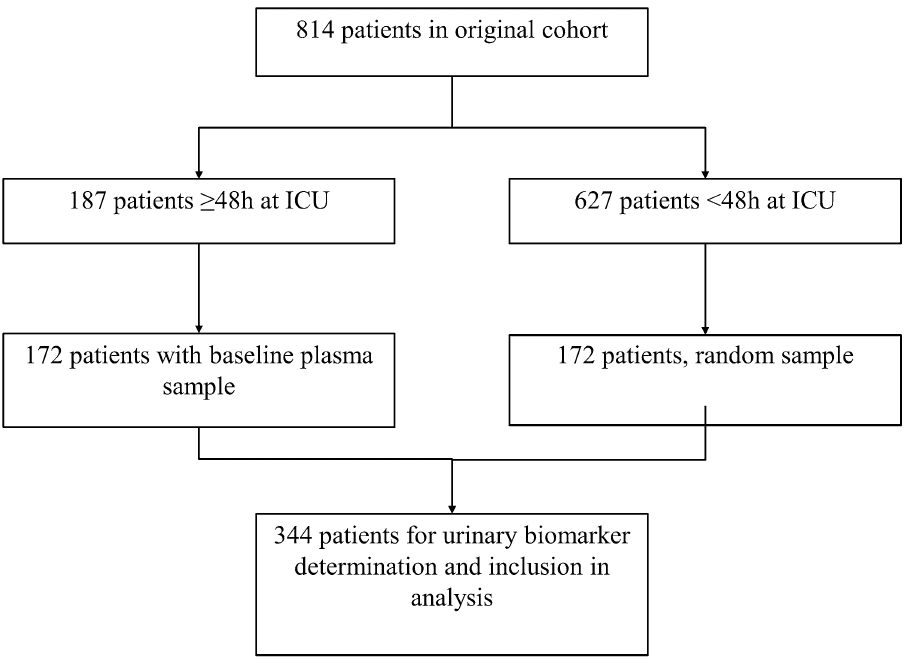
Figure 2. Flow chart of 344 patients available for analysis. ICU, intensive care